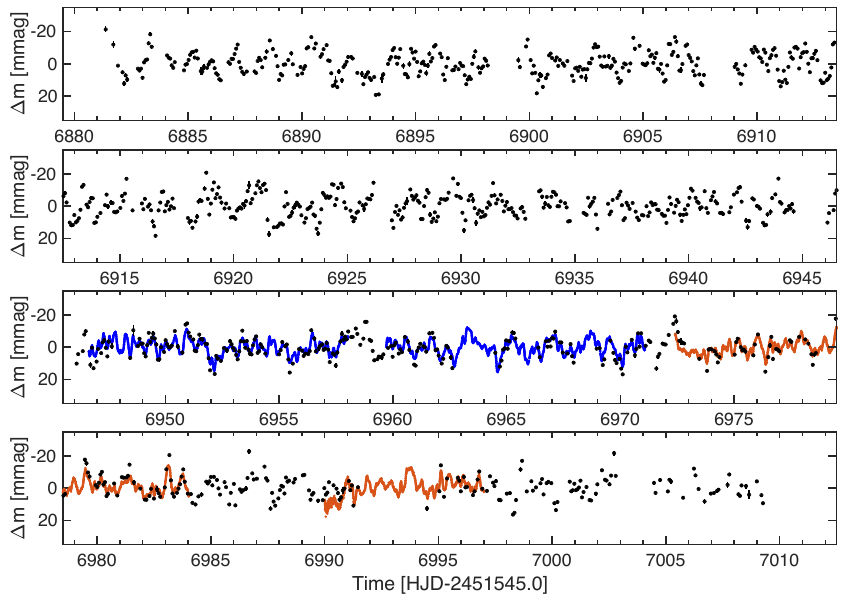
Figure 1. ζ Pup observed by BRITE-Heweliusz, a component of BRITE-Constellation, (black dots, red filter) and with TESS in sector 7 (first line in blue) and in sector 8 (second line in